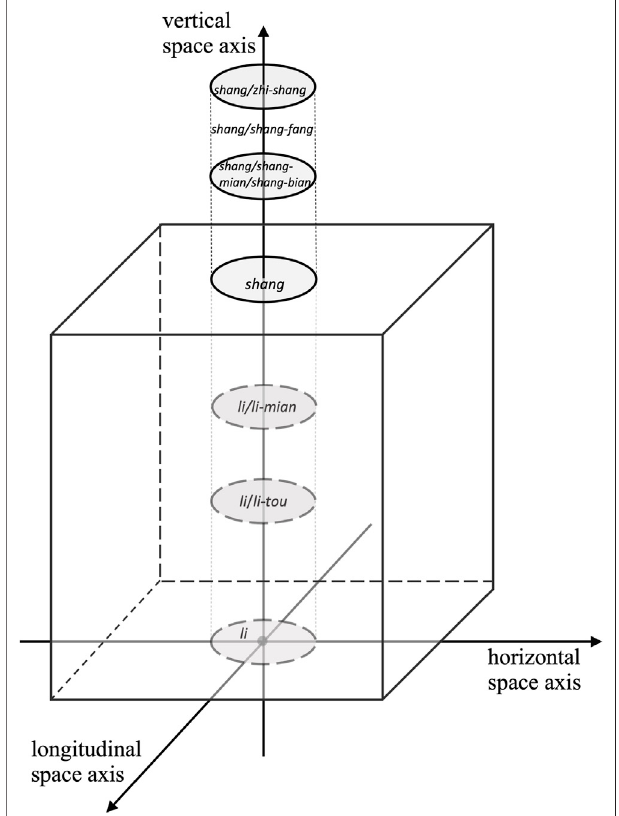
FIGURE 6 | The semantic map for shang and li . The map illustrates the locations that compound localisers li-mian and li-tou refer to. As the maps shows, li-tou refers to a perhaps more speci fi c location, an “ internal edge ” . Instead, li-mian refers to the “ internal side ” of an object. On the vertical axis, shang “ up ” refers to a cluster of locations (i.e., a region), zhi-shang “ far up, above ” to an upper location distant from the ground, and shang-mian / shang-bian to an “ up (per) side ” . Participants mostly considered zhi-shang and shang-fang as near-synonymous, as the map suggests.